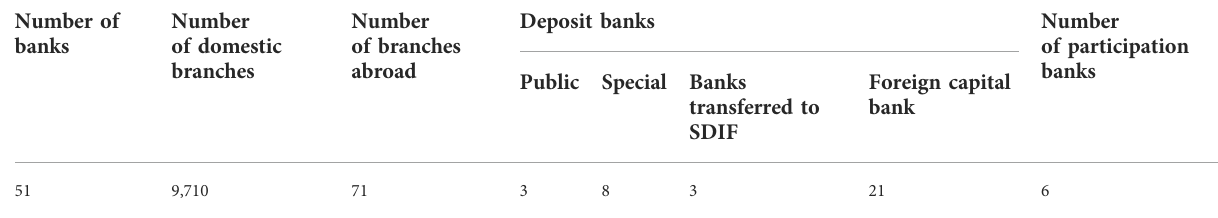
TABLE 2 Actual data of the fi nance sector as of May 2022.